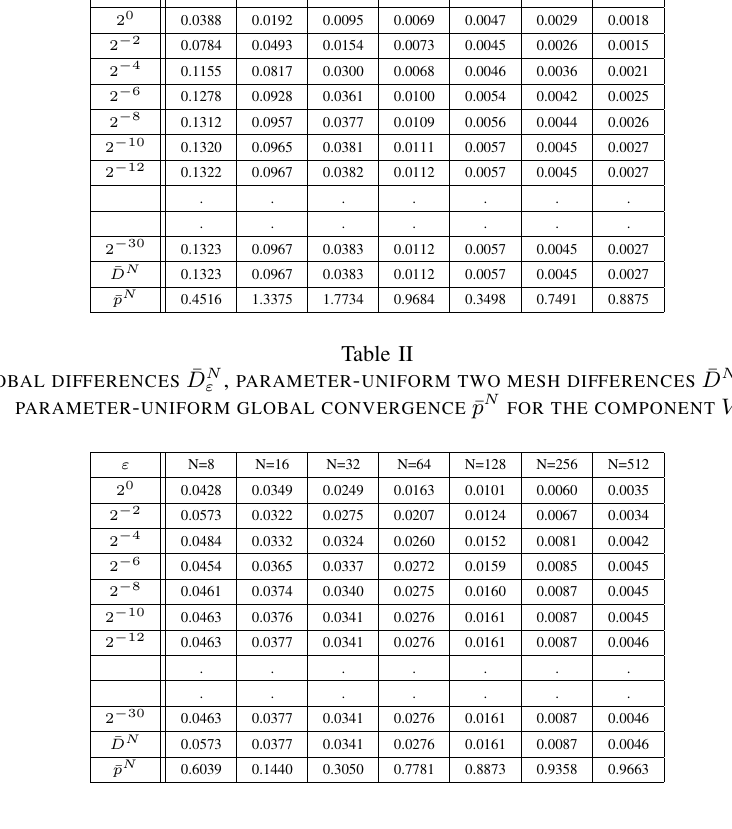
T WO MESH GLOBAL DIFFERENCES ¯ D N ε , PARAMETER - UNIFORM TWO MESH DIFFERENCES ¯ D N AND ORDERS OF PARAMETER - UNIFORM GLOBAL CONVERGENCE ¯ p N FOR THE COMPONENT U ε